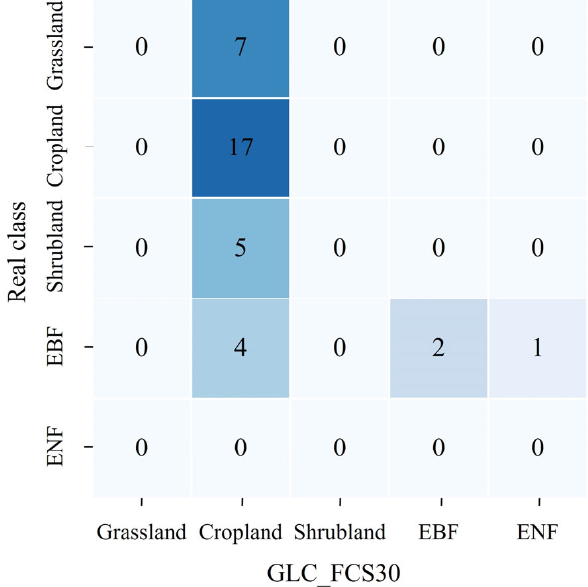
Figure 11. Confusion matrix: the horizontal is the predicted label (GLC_FCS30) and the vertical direction is the true label. EBF and ENF are evergreen broadleaf forest and evergreen needleleaf forest, respectively.